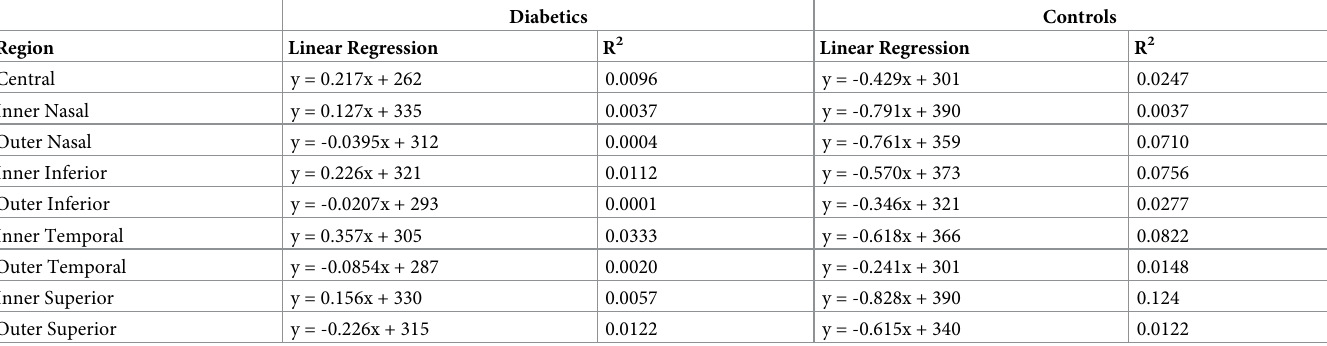
Table 2. Linear regressions and R 2 values for age vs ETDRS